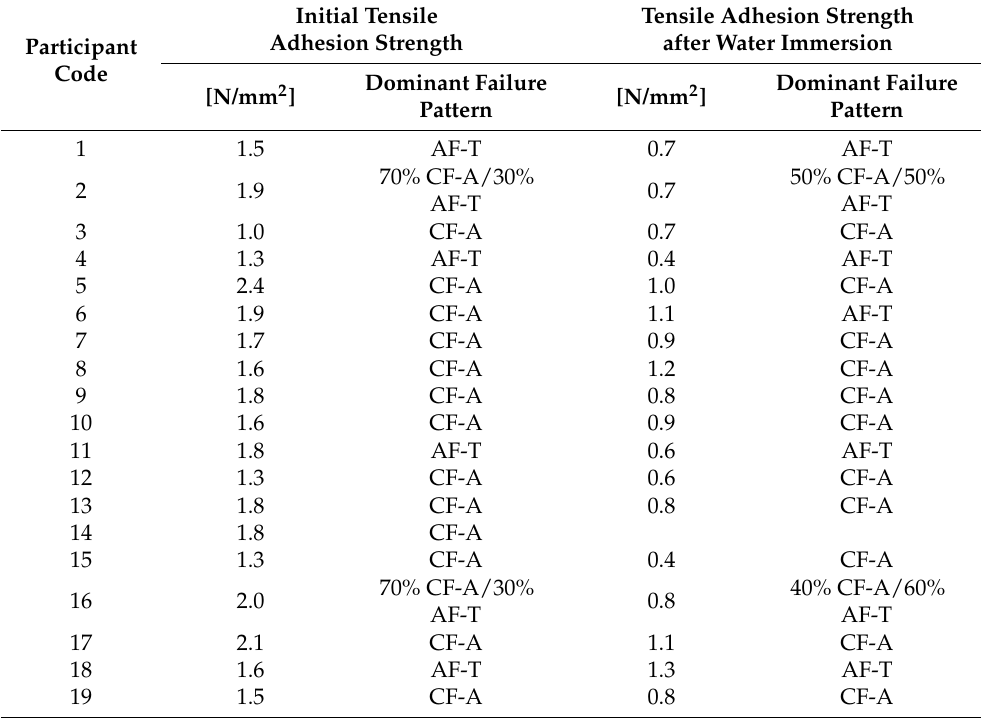
Table 1. The initial tensile adhesion strength and tensile adhesion strength after water immersion of CTA with the predominant mode of failure obtained by 19 laboratories in the eleventh ed. (2019–2020). Initial Tensile Adhesion Strength Participant Code